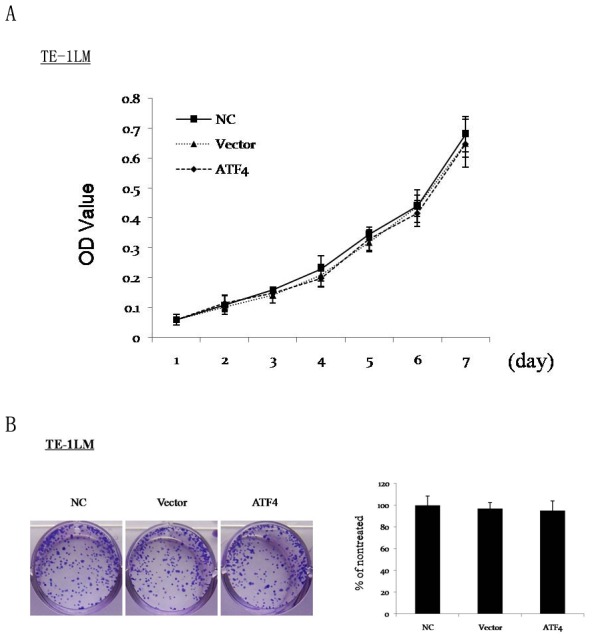
ATF4 does not affect the proliferation or colony formation of ESCC cells.(A) MTT assay of the proliferation of TE-1LM non-treated control (NC), TE-1LM-vector (Vector), and TE-1LM-ATF4 (ATF4) cells. The data represent the means ± S.D. of three independent experiments. (B) The effects of ATF4 on the proliferation of the cells as described above were also examined using a colony formation assay. The media was changed every 3 d. Cells were plated in triplicate, and the experiment was repeated three times. Representative wells are shown.